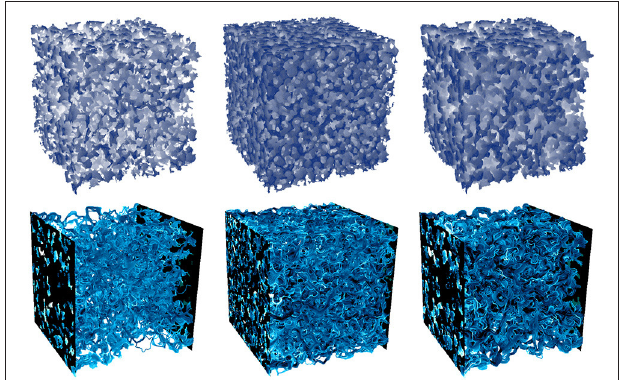
FIGURE 1 | Three-dimensional structure of FS 10 (left) , FS 25 (middle) , FSD 25 (right) samples. The top row displays the void space. The lines in the bottom panel show particle paths, the color scheme indicating the particle speed from white ( u / h u i ≤ 7 × 10 − 4 ) to dark blue ( u / h u i =